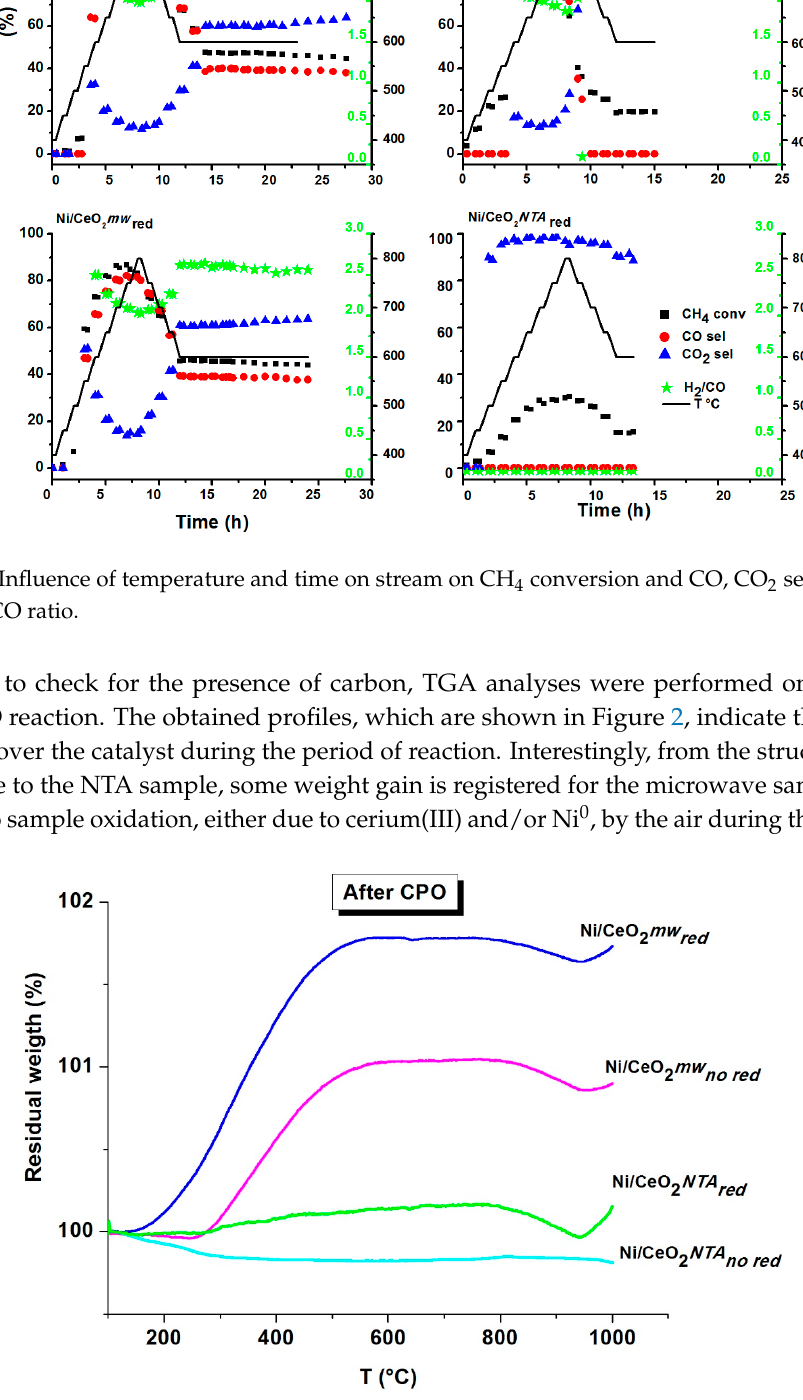
Figure 2. Thermogravimetric analyses (TGA) profiles of nickel catalyst after methane catalytic partial oxidation (CPOM) test.